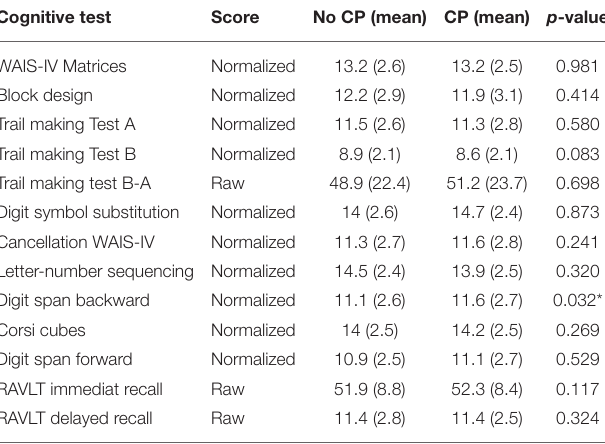
TABLE 3 | Mean normalized and raw scores in neuropsychological